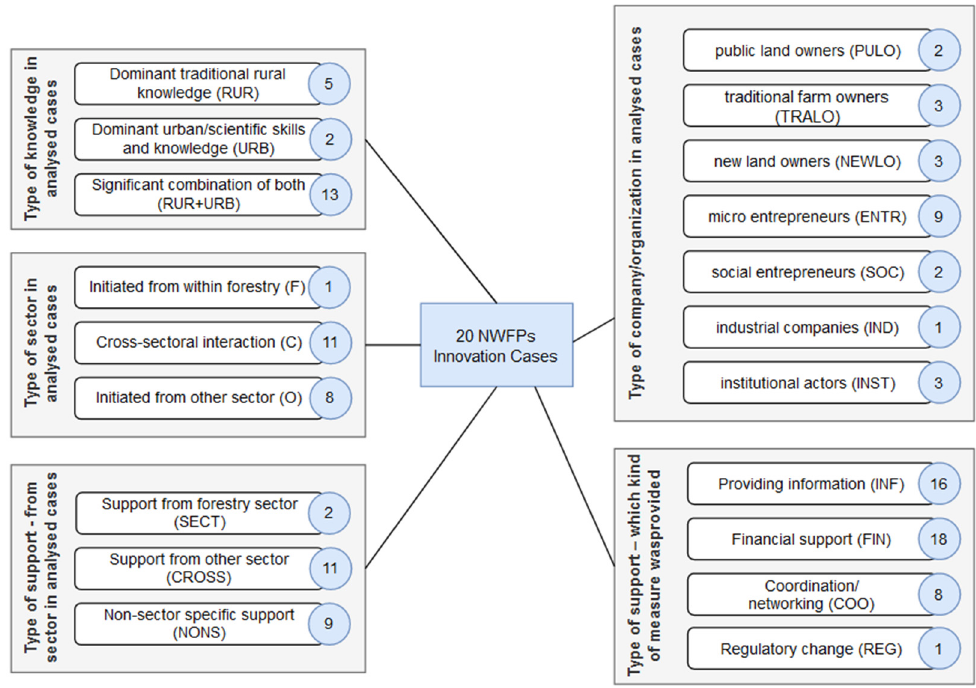
Figure 1. Analysis of NWFPs innovation cases (number in circles illustrate number of cases fitting into the category)